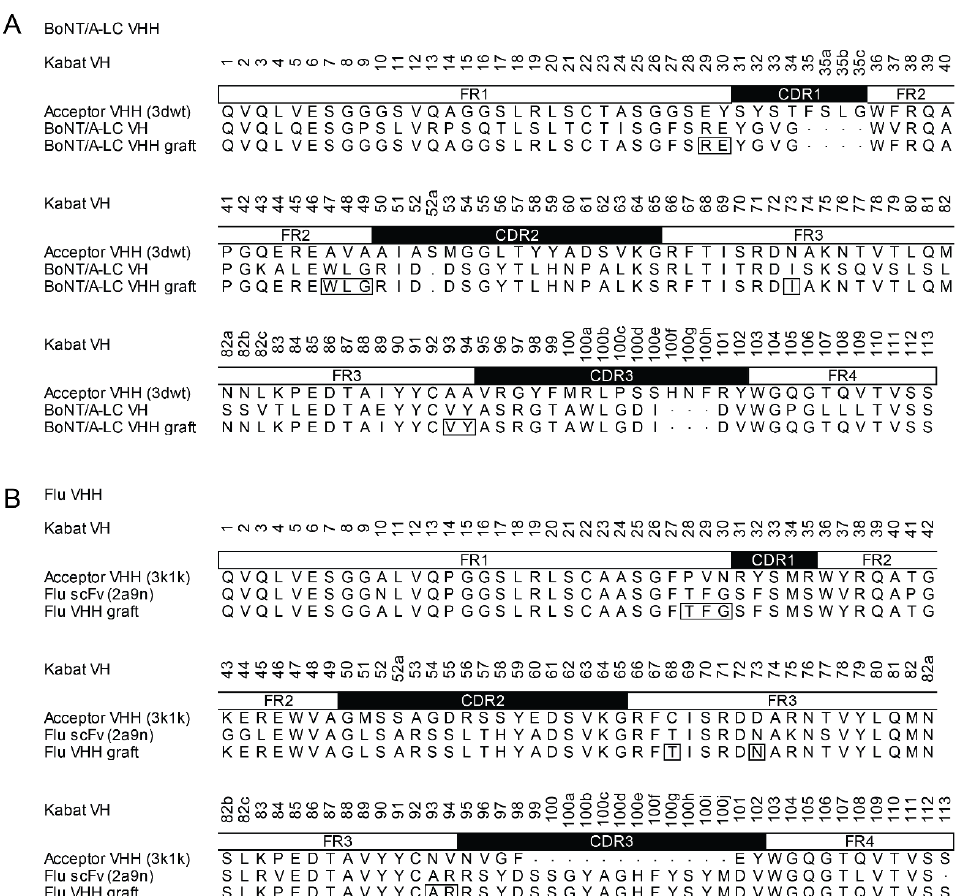
Figure 2. Sequence alignments of the complementarity determining region (CDR) donor VH, the acceptor VHH and the grafted VHH. ( A ) Design of a BoNT/A-LC-binding VHH. VH-CDRs of the BoNT/A-LC-binding scFv (FJ643069 [48]) were grafted onto the framework of the cAbBCII-10 nanobody (3dwt [45]). ( B ) CDR-grafting of a fluorescein-specific VHH. VH-CDRs of the Flu-scFv-E2 (2a9n [49]) were grafted onto the framework of the enhancer nanobody (3k1k [50]). Numbering